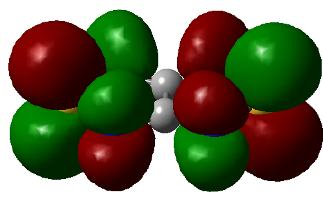
Figure 14. The π -SOMO of RA of compound 22